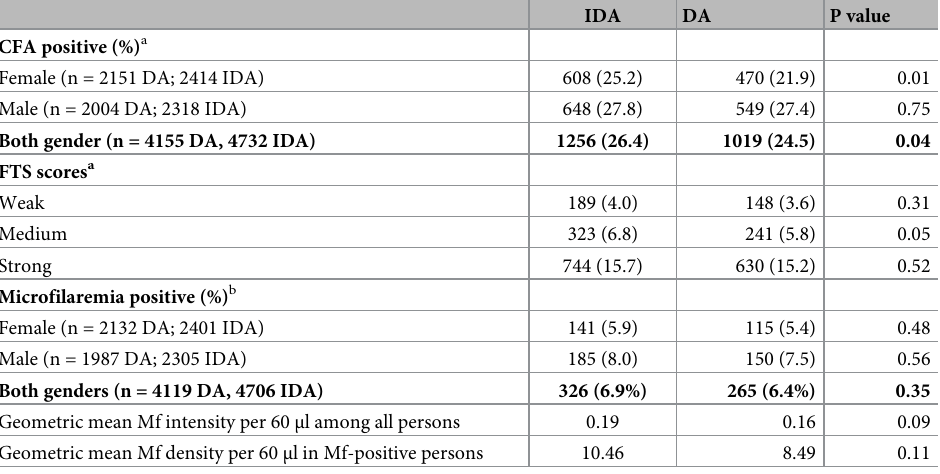
Table 2. Filarial infection status of the study population prior to